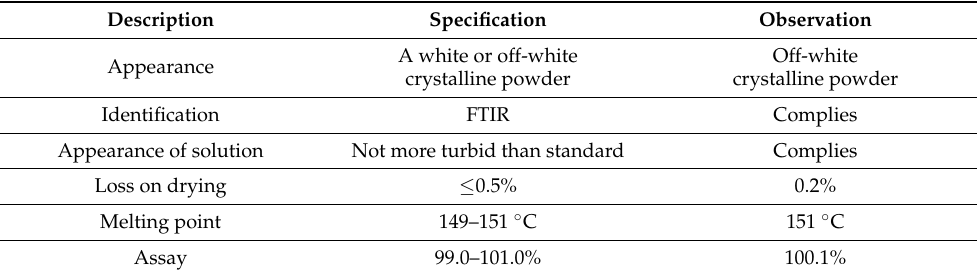
Table 1. The characterization of